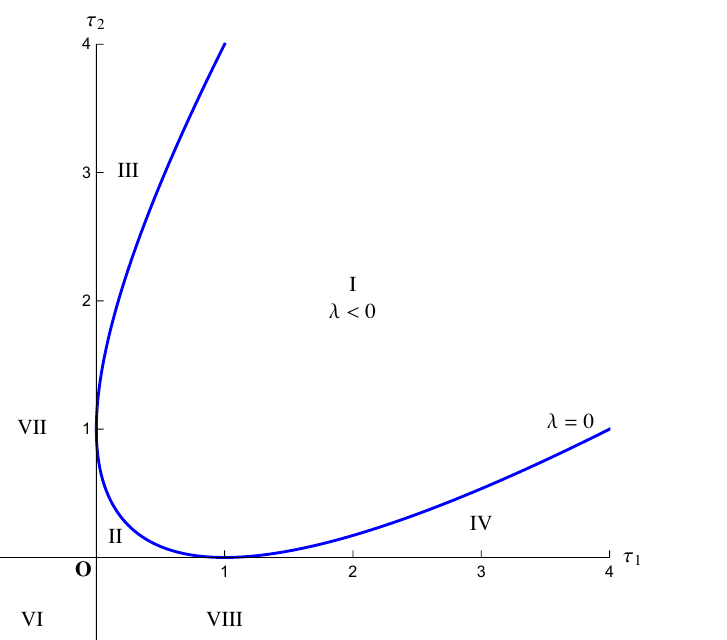
Figure 5. Regions of the ( (cid:28) )-plane classi(cid:12)ed in eq (5.8). Region V, which is identi(cid:12)ed by 1 ; (cid:28) 2